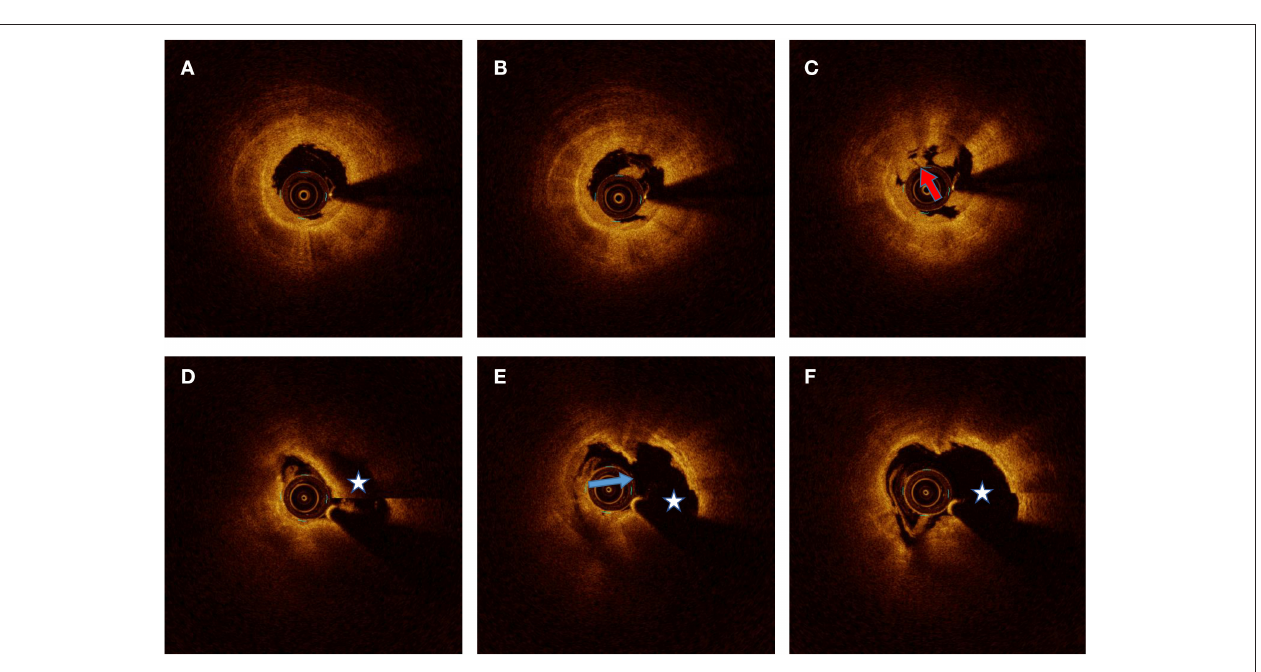
FIGURE 2 | Representative optical coherence tomography images for plaque erosion and rupture. (A–C) Plaque erosion defined by residual white thrombus (red arrow) underlying a fibrous plaque without evidence of fibrous cap disruption. (D–F) Plaque rupture identified by the presence of disrupted fibrous cap (blue arrow) and cavity formation